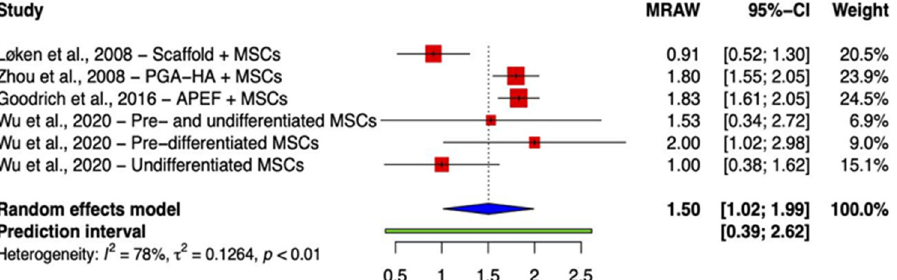
Figure 1. Forest plot on the mean histological integration score after receiving BMSC implant therapy, where 2/2 points = both edges integrated, 1/2 = one edge integrated, and 0/2 = no integration. (Abbreviations: MSC, mesenchymal stem cell; PGA-HA, polyglycolic acid-hydroxyapatite; APEF, autologous platelet-enhanced fibrin; CI, Confidence Intervals) [23,29,32,33].